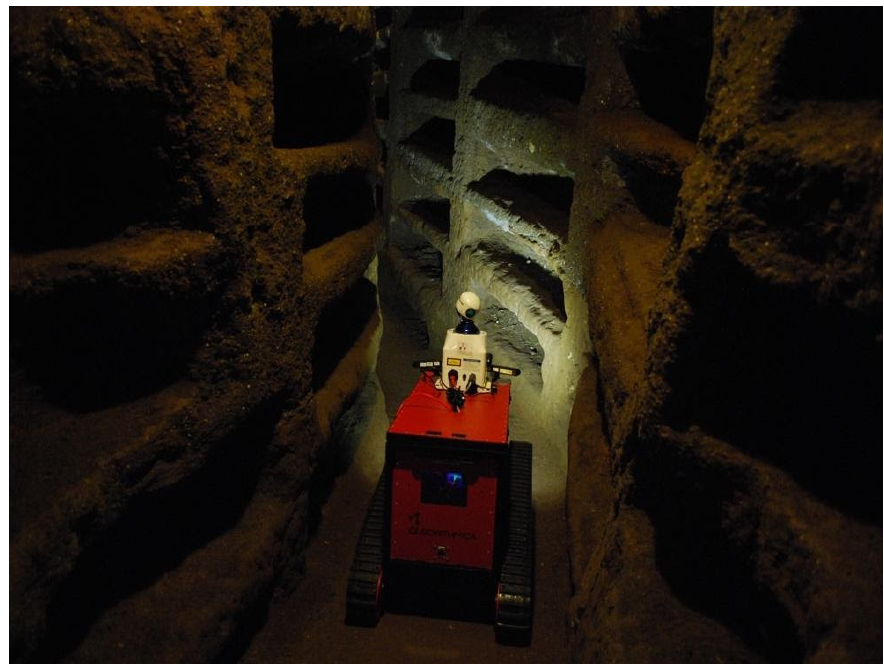
Figure 4. The ROVINA project demonstrated the ability to produce a rover capable of sophisticated exploration and mapping (ROVINA Project).